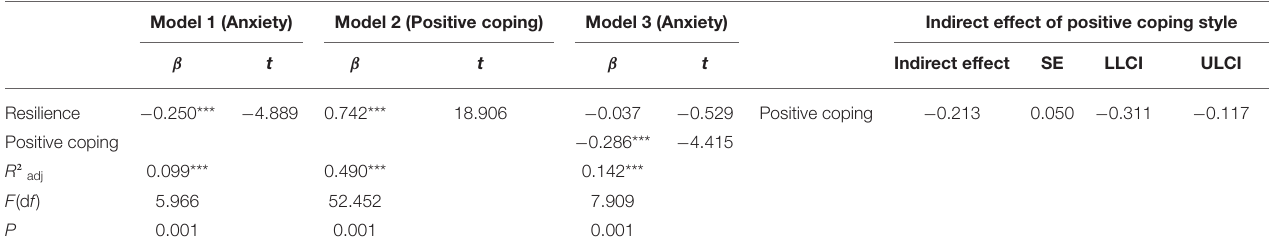
TABLE 3 | Mediation analysis ( N =